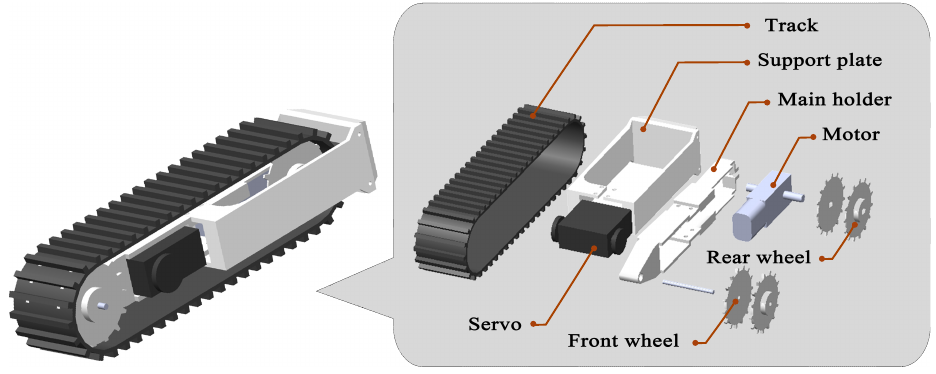
Figure 2. The tracked foot structure.